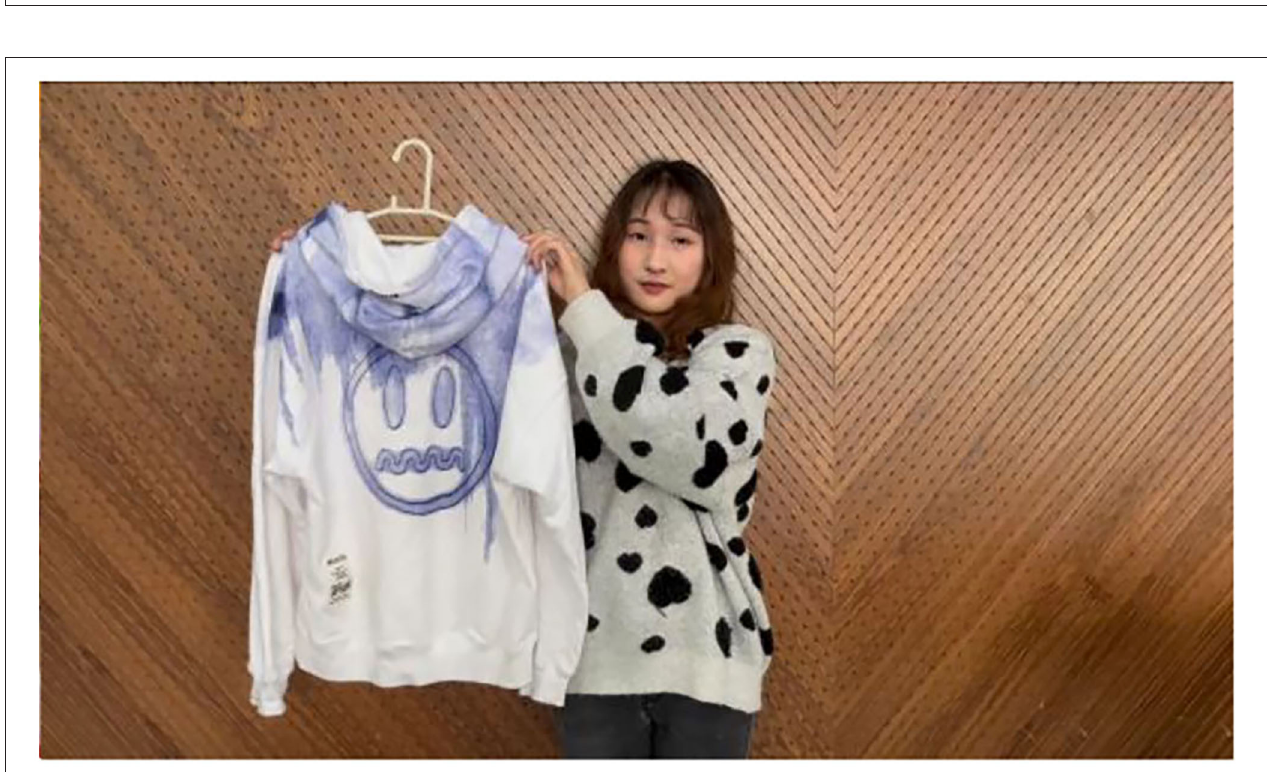
FIGURE 6 | B2 Screenshot of low